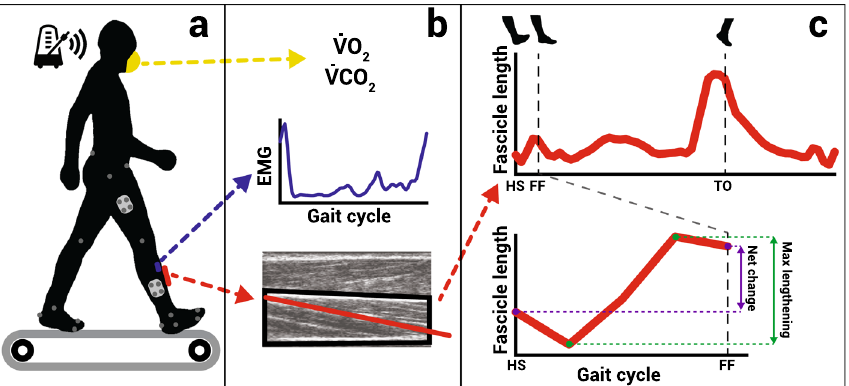
Figure 6. ( a ) Subjects walked to a metronome beat on a treadmill at a set speed. ( b ) We measured whole body indirect calorimetry (yellow) as well as EMG (blue) and B-mode ultrasound (red) from the TA muscle during walking. ( c ) We determined gait events such as heel strike (HS), foot-flat (FF), and toe-off (TO) using retroreflective markers and ground reaction force measurement. We used the ultrasound images to measure TA muscle fascicle length across the gait cycle (top). We calculated the net length change (purple) and single maximum lengthening episode (green) of the fascicle during the period between heel strike and foot-flat